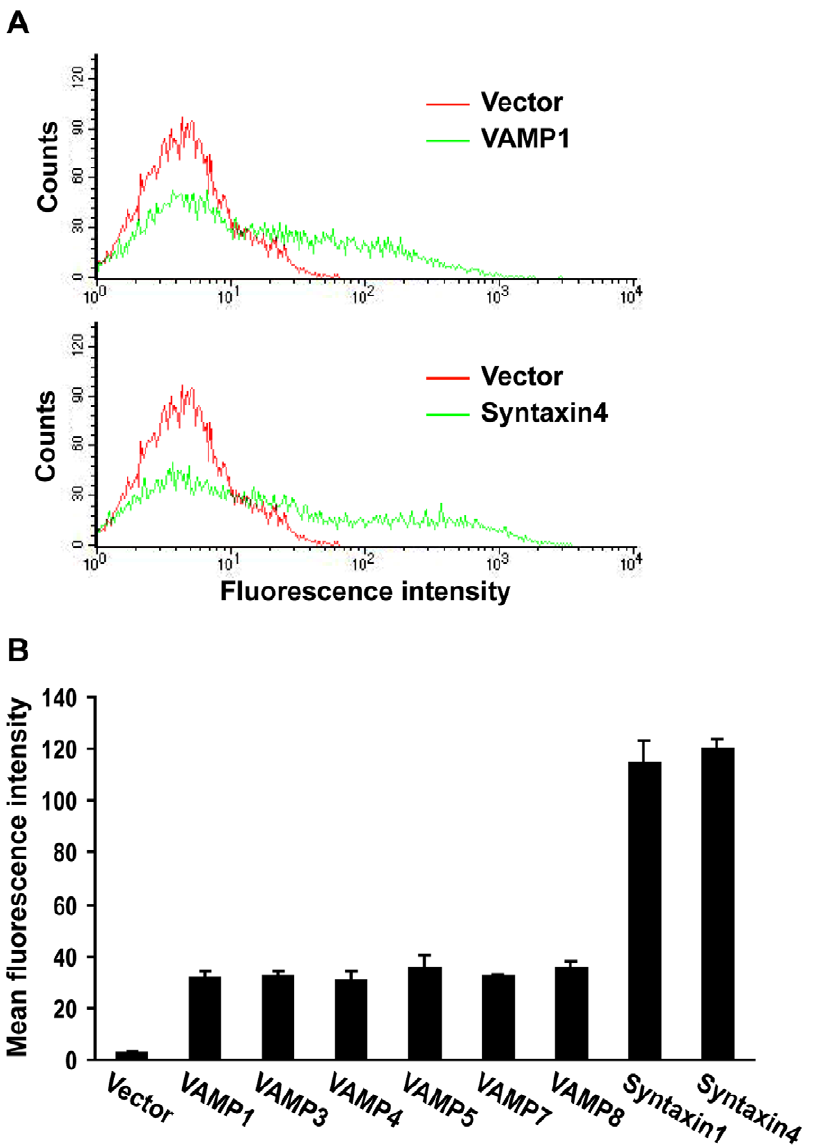
Figure 4. FACS analysis of SNARE expression at the cell surface. 24 h after cotransfection with tTA and the empty vector, flipped VAMPs 1, 3, 4, 5, 7 or 8 (v-cells), or 24 h after cotransfection with TRE- LacZ , flipped SNAP-25 and syntaxins 1 or 4 (t-cells), unpermeabilized COS-7 cells were stained with an anti-Myc antibody, and then analyzed by flow cytometry. (A) Representative FACS profiles of the cells transfected with the empty vector, flipped VAMP1 or syntaxin4/SNAP-25. (B) To express the v- and t-SNAREs at same level at the cell surface, flipped SNARE plasmids were transfected at the following concentrations (per 10 cm 2 growth area, i.e. , per well in 6-well plates): VAMP1, 0.2 m g; VAMP3, 0.5 m g; VAMP4, 0.5 m g; VAMP5, 0.05 m g; VAMP7, 1.0 m g; VAMP8, 0.1 m g; syntaxin1, 0.5 m g; syntaxin4, 0.05 m g. tTA, TRE- LacZ and flipped SNAP-25 were cotransfected at 1 m g per 10 cm 2 growth area. The mean fluorescence intensity of staining of the SNAREs was determined by FACS analysis. Error bars represent standard deviation of four independent